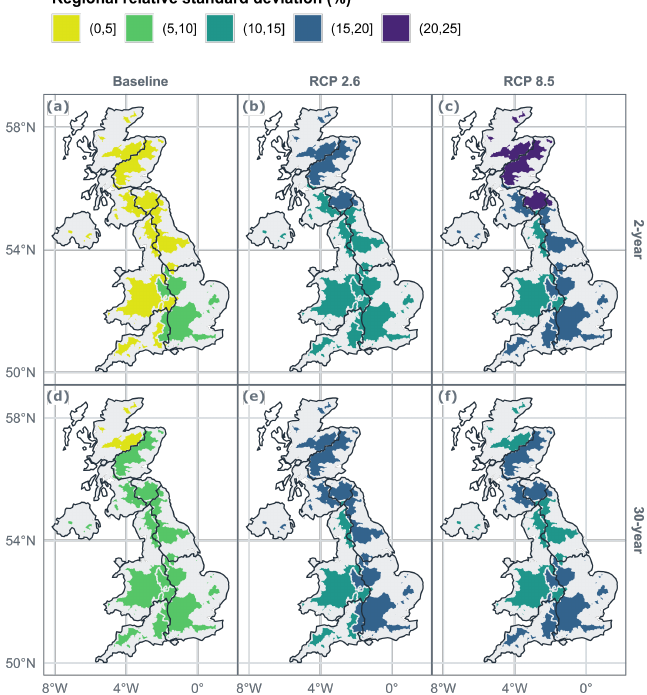
Figure 5. Regional relative standard deviation (RSD) across the UK using the GEV distribution for the ( a ) 1:2-year RP over the baseline (1971–2000); ( b ) 1:2-year RP over the 2080s (2069–2098) under RCP 2.6; ( c ) 1:2-year RP over the 2080s under RCP 8.5; ( d ) 1:30-year RP over the baseline; ( e ) 1:30-year